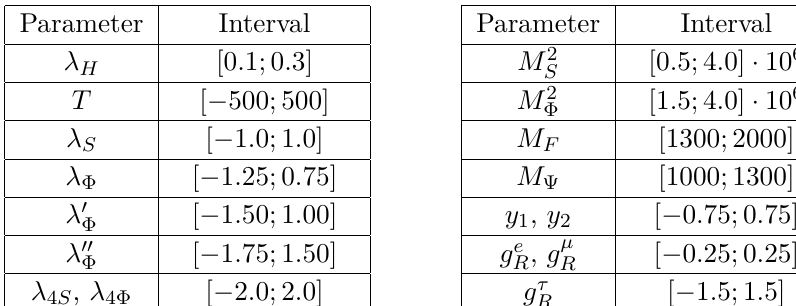
Table 5 . Intervals for the model parameters which can be expected to lead to viable parameter configurations obtained from the Markov Chain Monte Carlo analysis. All dimensionful parameters are given in GeV. Approximate viable intervals for the coupling parameters g i can be extracted from figure 7.